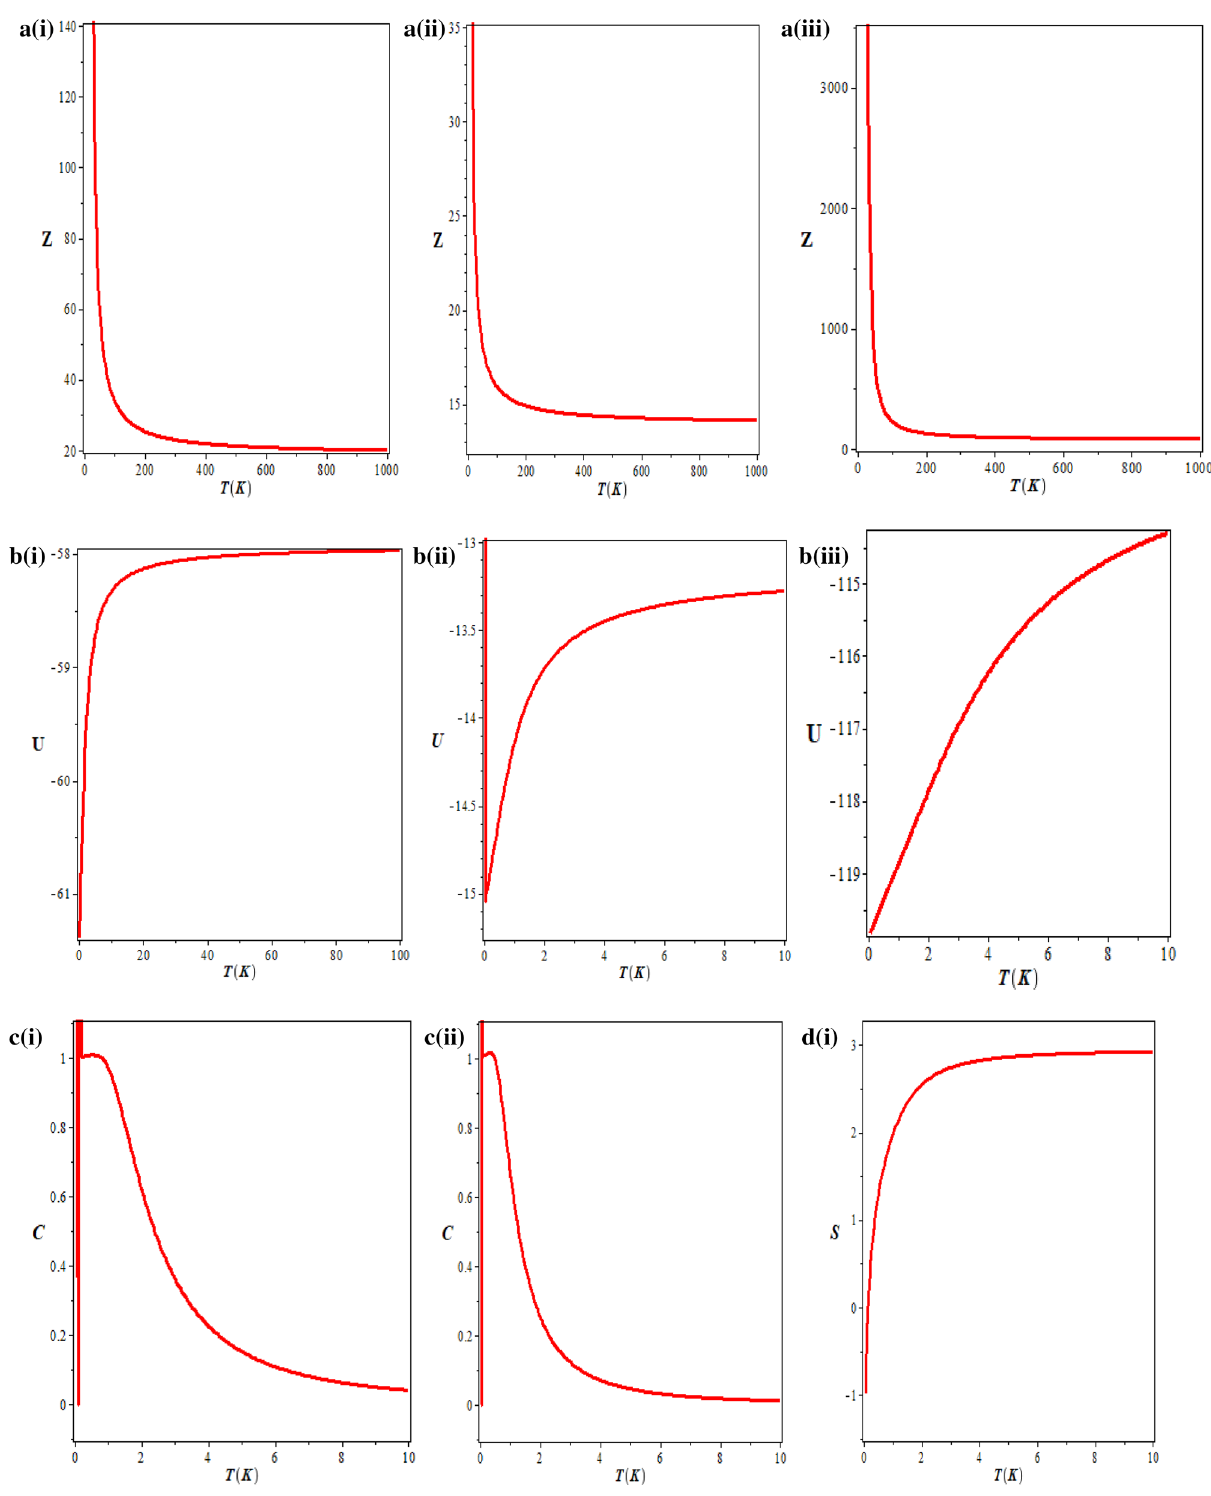
Figure 5. ( a )(i) Vibrational partition function against temperature for HF. ( a ) (ii) Vibrational partition function against temperature for H 2 . ( a ) (iii) Vibrational partition function against temperature for CO. ( b ) (i) Vibrational mean energy against temperature for HF. ( b ) (ii) Vibrational mean energy against temperature for H 2 . ( b ) (iii) Vibrational mean energy against temperature for CO. ( c ) (i) Vibrational specific heat capacity against temperature for HF. ( c ) (ii) Vibrational specific heat capacity against temperature for H 2 . ( d ) (i) Vibrational entropy against temperature for HF. ( d ) (ii) Vibrational entropy against temperature for H 2 . ( d ) (iii) Vibrational entropy against temperature for CO. ( e ) (i) Vibrational free energy against temperature for HF. ( e ) (ii) Vibrational free energy against temperature for H 2 . ( e ) (iii) Vibrational free energy against temperature for